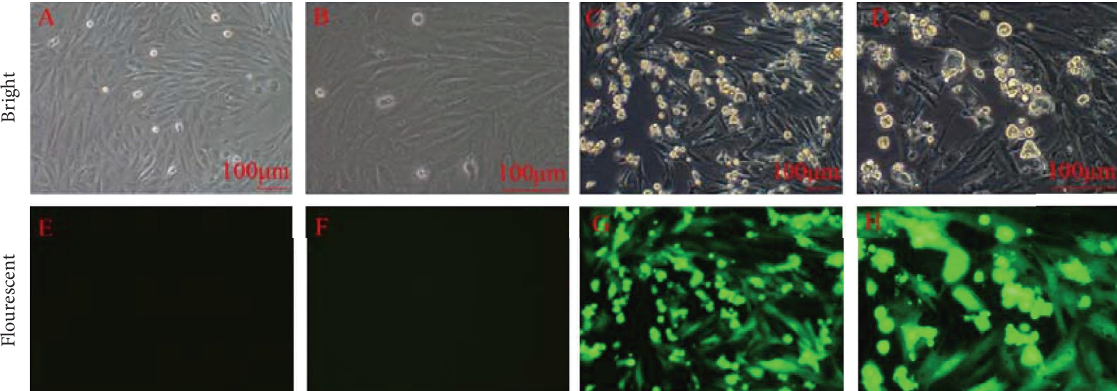
Figure 3: GFP expression in H9c2 cells. (a, e) H9c2 cells cultured under regular circumstances without virus were normal in the bright and fuorescent feld, respectively (10x); (b, f) the same scene as (a) and (e) but under 20x feld correspondingly; (c, f) H9c2 cells were incubated with recombinant adenoviruses at MOI � 100 in the bright and fuorescent feld (10x); (d, g) the same scene as (c) and (f) but under 20x feld (GFP: green fuorescent protein).